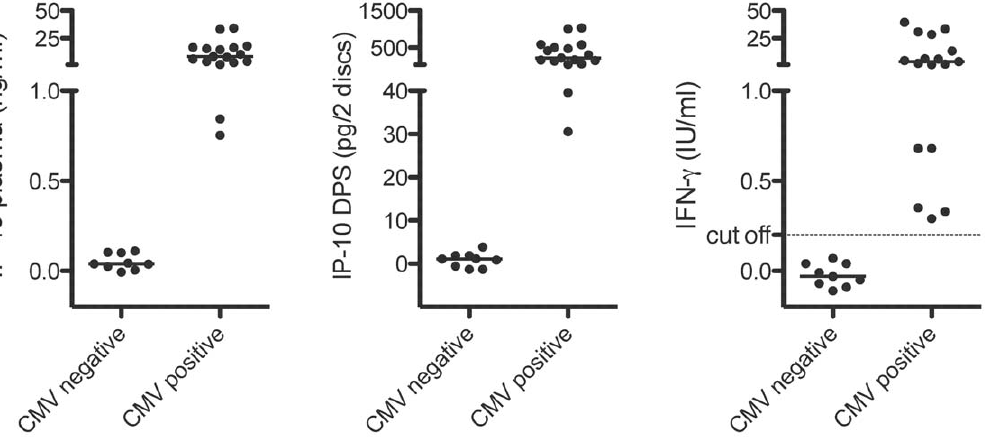
Figure 5. IP-10 responses in plasma and DPS. QFT-CMV responses from 26 healthy individuals (Control group 2) were divided into CMV-positive (n=17) and CMV-negative (n=9) based on the QFT-CMV cut off for IFN- c suggested by the manufacturer (0.2 IU/ml).